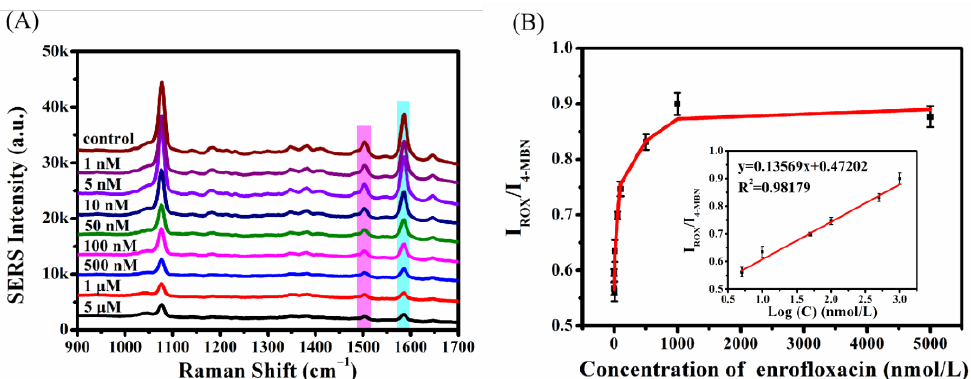
Figure 8. Determination of enrofloxacin using the established ratiometric SERS aptasensor. ( A ) SERS spectra of enrofloxacin at concentrations of 0 (control), 1 nM, 5 nM, 10 nM, 50 nM, 100 nM, 500 nM, 1 µM, and 5 µM. ( B ) Calibration curve (main panel) and linear dynamic range (inset panel) of the established ratiometric SERS aptasensor.